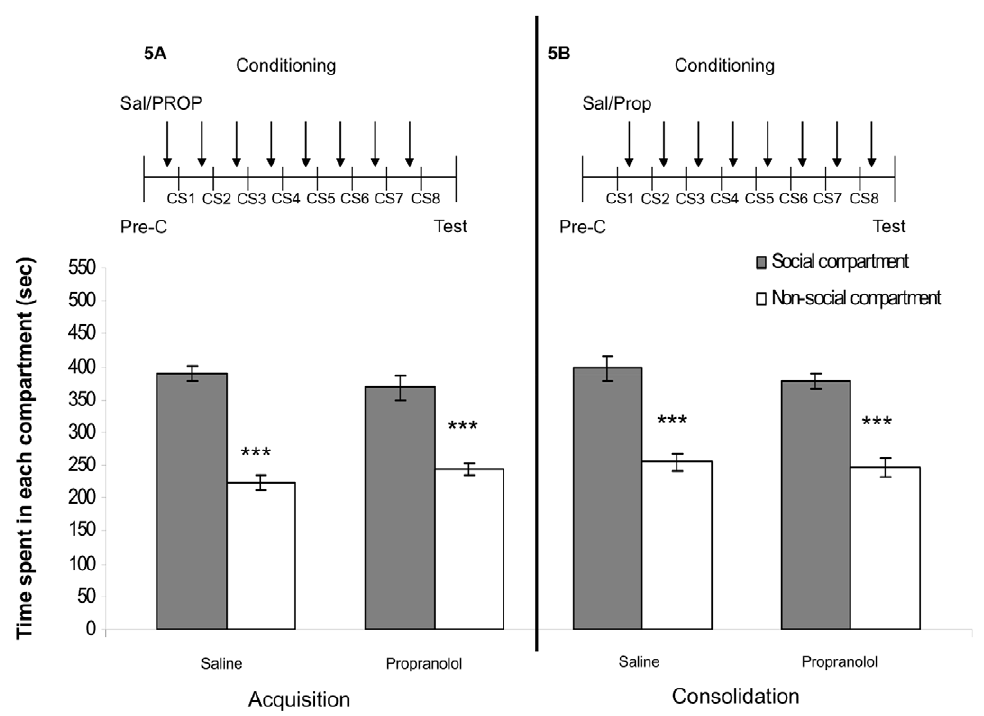
Figure 5. Effects of PROP on acquisition (panel A) and consolidation (panel B) of social play-induced CPP. The experimental protocol is depicted above the graph (Pre-C: pre-conditioning test, CS: daily conditioning sessions, consisting of one session with and one session without a play-partner present). PROP was administered either 30 min before (acquisition) or immediately after (consolidation) each conditioning session. Data represent the mean time (sec 6 SEM) spent in the social compartment (grey bars) and the non-social compartment (white bars) during a 15 min retrieval-session. Saline-treated animals (2 ml/kg, i.p. , acquisition: n=16, consolidation: n=12), PROP-treated animals (10 mg/kg, i.p. , acquisition: n=16, consolidation: n=12). Post-hoc Student’s paired t-tests for difference in time spent in the social- and non-social compartment **p , 0.01, ***p , 0.001.